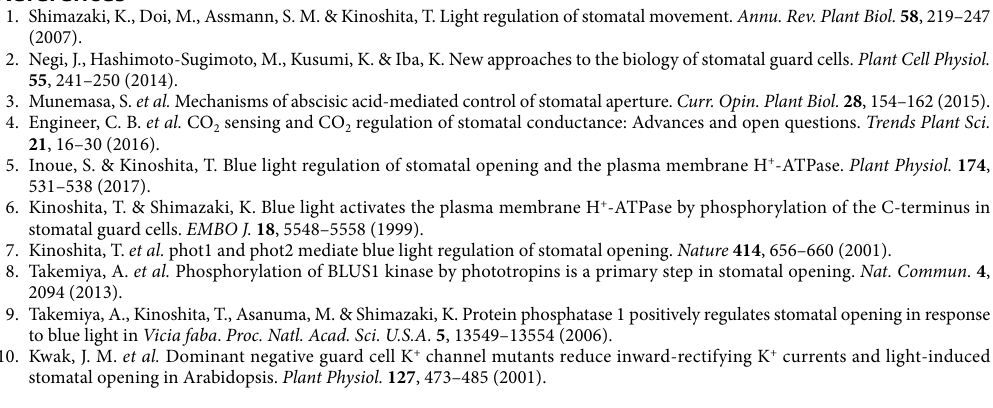
study complies with the IUCN Policy Statement on Research Involving Species at Risk of Extinction and the Convention on the Trade in Endangered Species of Wild Fauna and Flora. Chemical library screening. We screened a total of 22 compounds from the homemade sulfonimide compound collection. Compounds were dissolved in dimethyl sulfoxide (DMSO) at a concentration of 10 mM. Each com- pound was added at a 1:200 dilution to basal buffer (5 mM MES/bistrispropane [pH 6.5], 50 mM KCl, and 0.1 mM CaCl 2 ) for a final concentration of 50 µM. C. benghalensis plants were first incubated in the dark over- night to ensure complete closure of stomata prior to assay. Using such plants, under dim light, 1–2 cm 2 epidermal peels were excised from fully expanded leaves using scissors and forceps. The epidermal peels were immersed in the buffer containing chemical compounds and were incubated under fluorescent white light (50 μmol m −2 s −1 ) or in the dark at 25 °C for 4 h, and samples in which the stomata were uniformly closed were identified using a stereoscopic microscope (Stereo Discovery; Zeiss, Oberkochen, Germany). Measurement of stomatal apertures. Samples of C. benghalensis were prepared as described above, while epider- mal fraction of fully expanded rosette leaves from 5 to 7-week-old plants of Arabidopsis thaliana was prepared as described previously 23 . For the light irradiation, 50 µmol m −2 s −1 red light and 10 µmol m −2 s −1 blue light were used instead of white light. After treatment of compounds in varying concentration, images were acquired using an optical microscope (BX43; Olympus, Tokyo, Japan) with a charge-coupled device (CCD) camera (DP27; Olympus) with a × 10 objective lens (UPlanFL N; Olympus). Stomatal apertures of respective stomata were measured using FLUOVIEW software (Olympus). Quantification of the degree of H + ‑ATPase phosphorylation. Phosphorylation of PM H + -ATPase in hypocotyls or guard cells from the epidermis of Arabidopsis was determined by immunoblot or by immunofluorescence, respectively, as described previously 42,43 . Fluorescein diacetate staining assay. Fluorescein Diacetate Staining Assay to determine to guard cell viability of C. benghalensis was determined as described previously 23 .